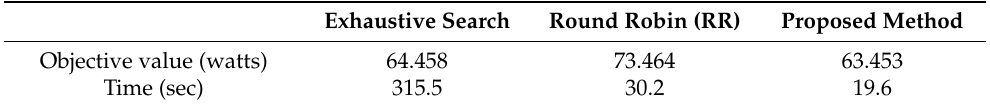
Table 5. Performance Analysis